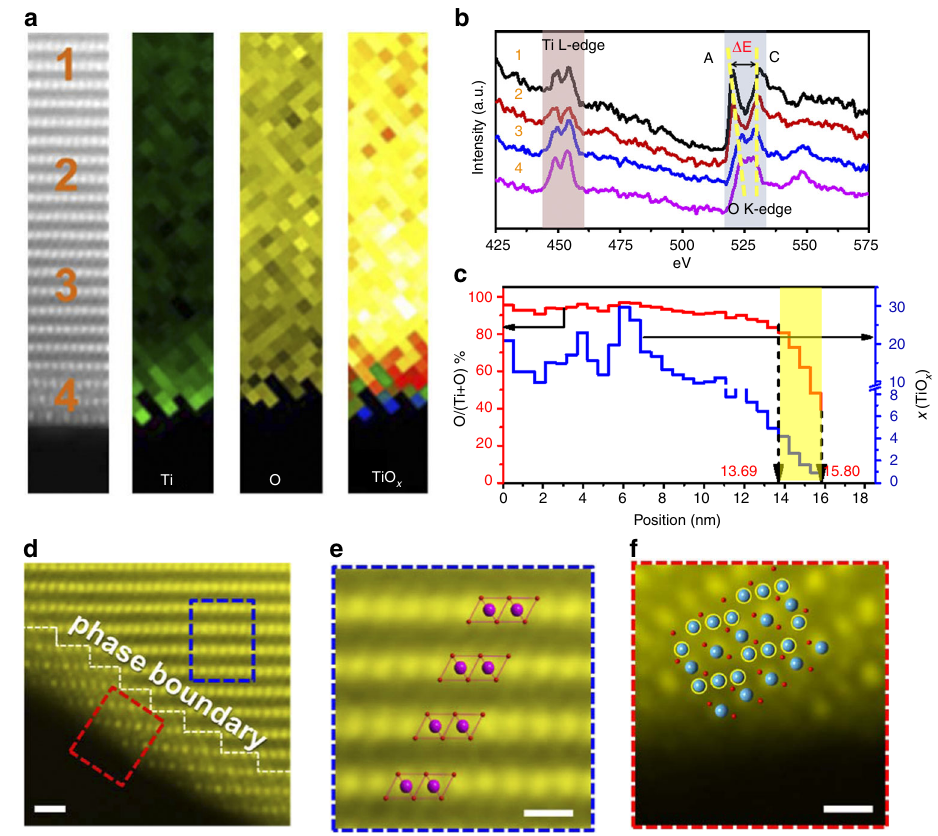
Fig. 2 Oxidation state, composition, and crystalline phase of the local fi ne structure of the NMTN samples. a HADDF-STEM and EELS mapping images focusing on the Ti and O composition and chemical shift from the core to the shell for a typical location; the numerical marks indicate the selective spots for EELS. b Energy-loss near-edge spectrum (ELNES) of the Ti-L 2,3 ( vertical brown shading ) and O-K ( vertical blue shading ) edges, wherein the yellow dotted lines show peak A and peak C of the O-K edges. c Chemical composition of Ti and O, in which the vertical yellow shading represents the location of the interface; d STEM-HADDF image, indicative of the zigzag phase boundary; scale bar, 1 nm. e Magni fi ed image extracted from the blue rectangle of d , assigned to the typical layered stacking in the bulk; scale bar, 0.5 nm. f Magni fi ed image extracted from the red rectangle of d , showing the spinel-like stacking at the interface; scale bar, 0.5